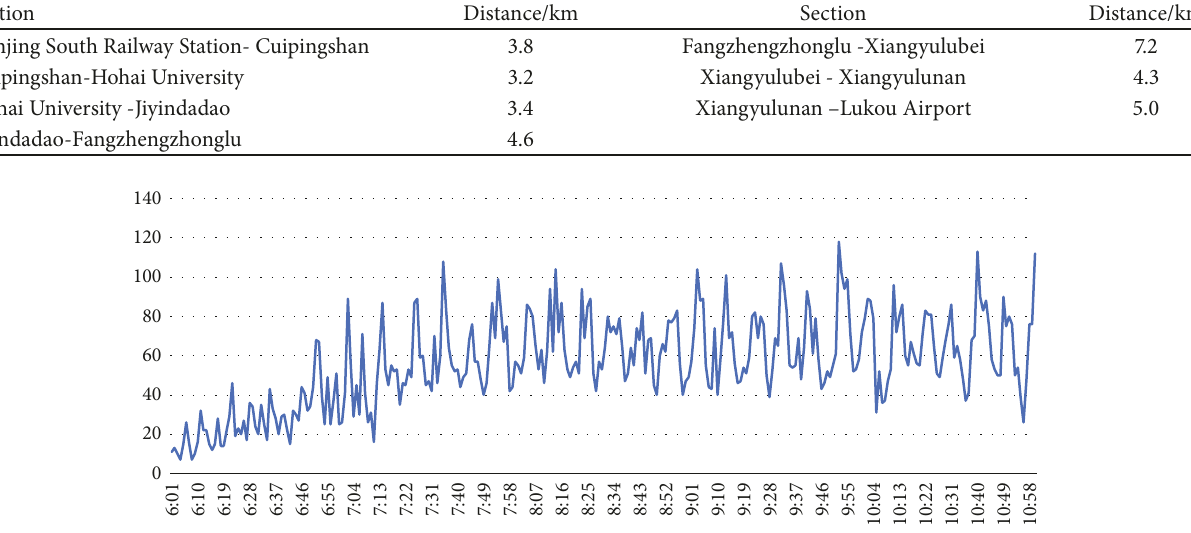
Figure 3 is an average running speed based on distance